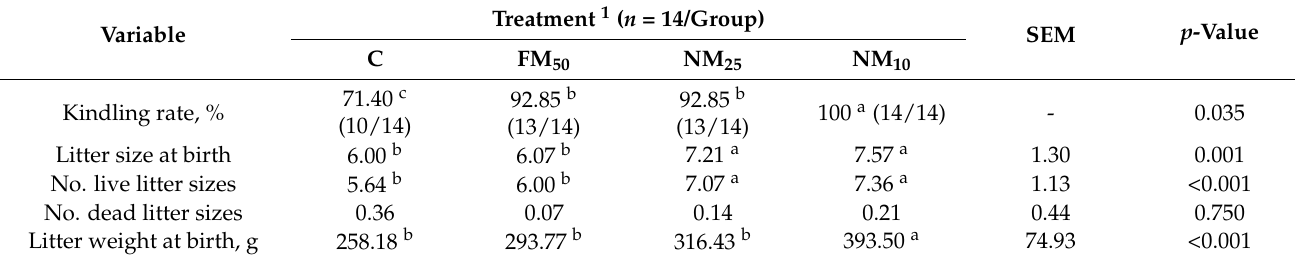
BW nanoencapsulated MLEE. Means within the same physiological status having different superscripts (a, b, c) differ significantly ( p < 0.05).